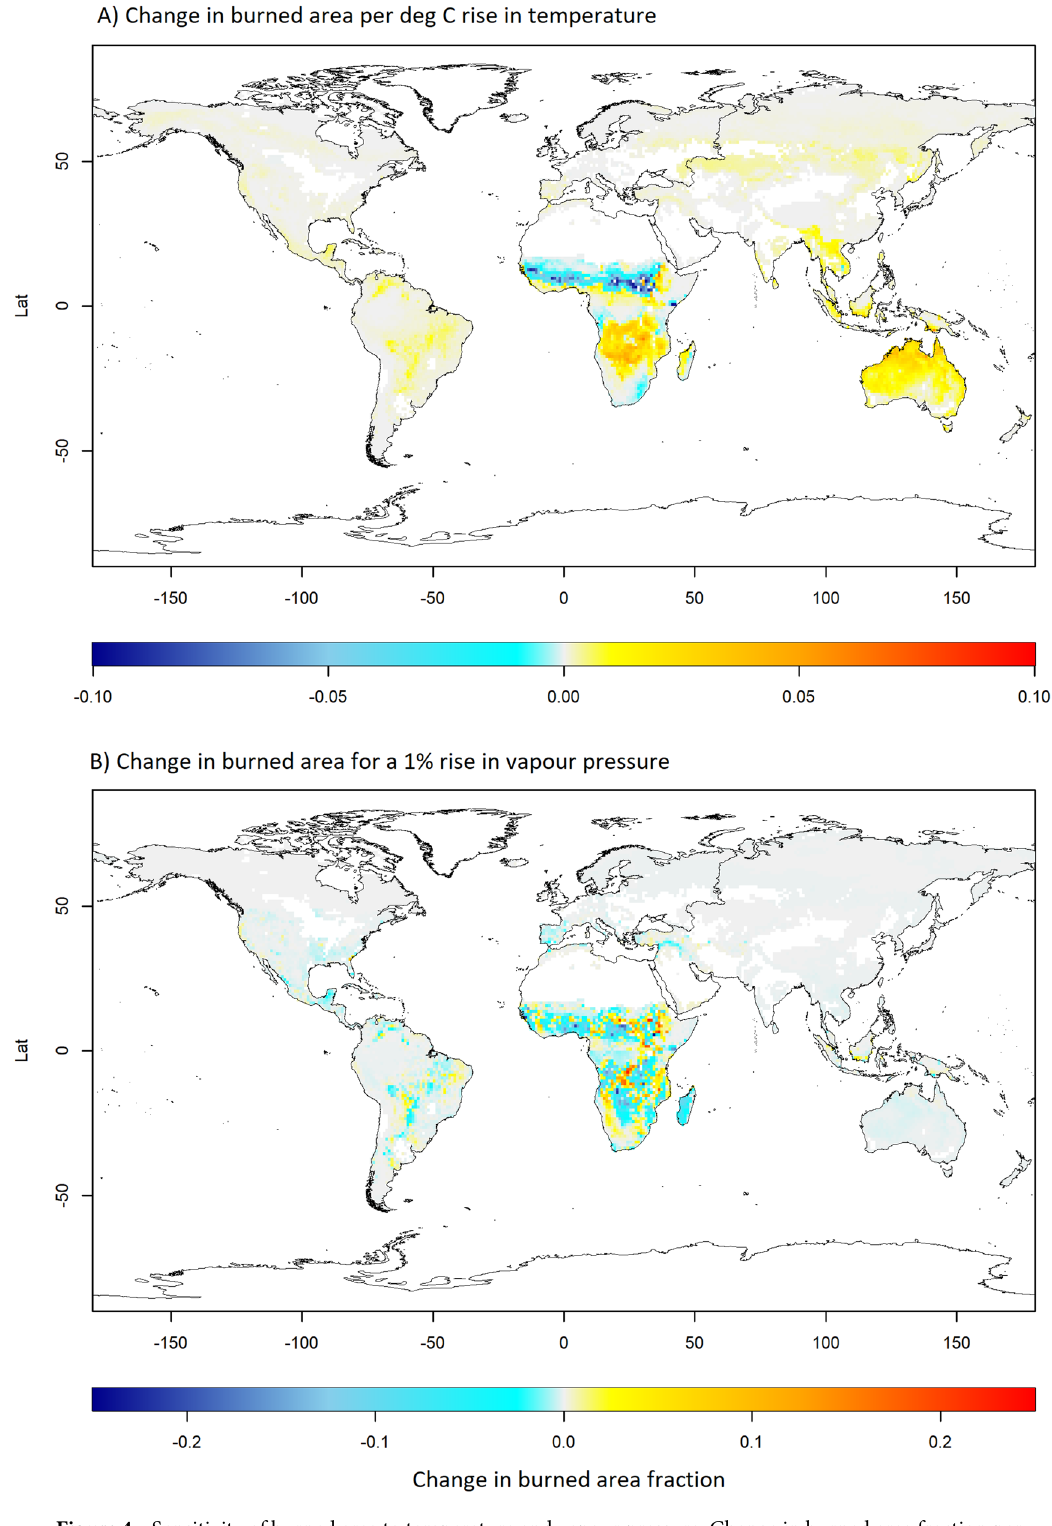
Figure 4. Sensitivity of burned area to temperature and vapour pressure. Change in burned area fraction per ◦ C rise in temperature ( A ) and for a 1% increase in vapour pressure ( B ). While incrementing either variable, all other variables were held equal to their original